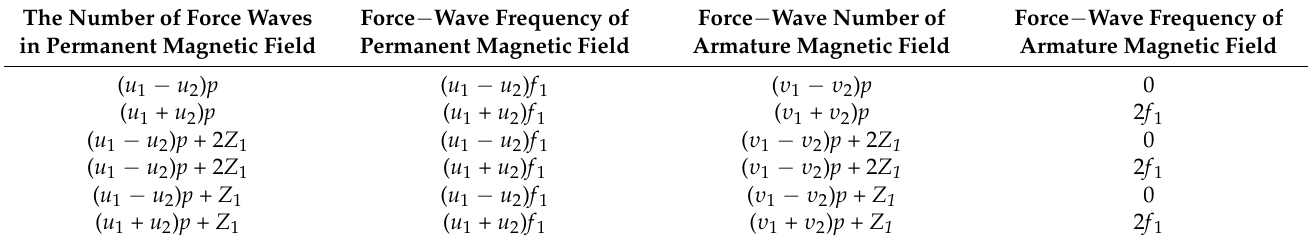
Table 2. Number of electromagnetic force waves and frequency.